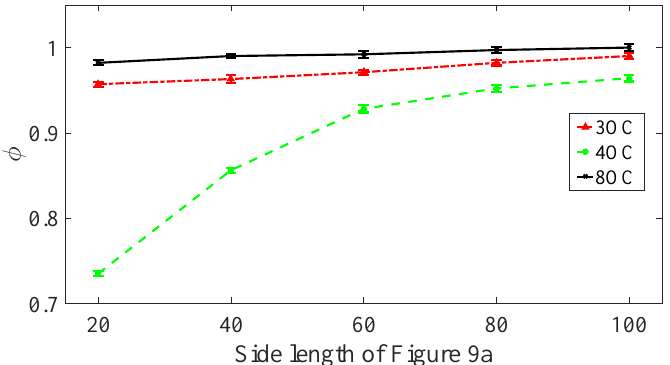
Figure 9. Effect drawing of the ST approach, A* algorithm and Dijkstra algorithm: ( a ) Marked key cells; ( b ) Result of tracking.